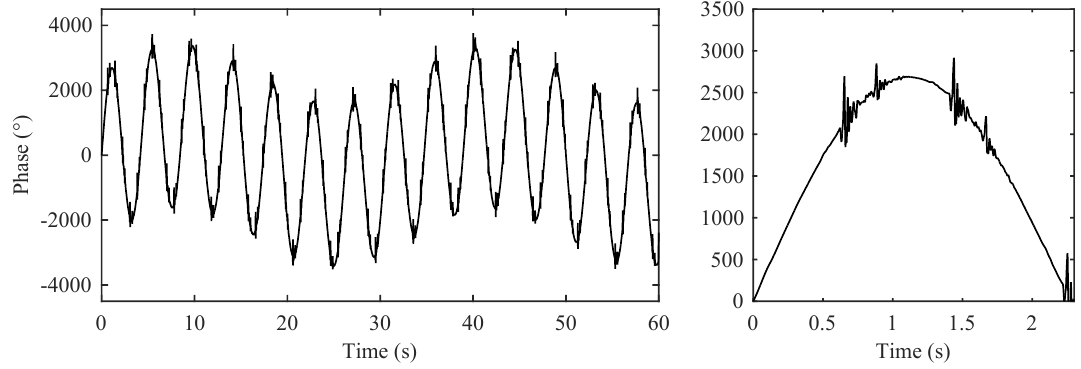
Figure 7. Modelled raw signal measured by IS T in the abdominal region (mRR ∈ <12–16> rpm; mHR ∈ <65–85> bpm). ( Left ) 60 s; ( Right ) detail in the form of 2.3